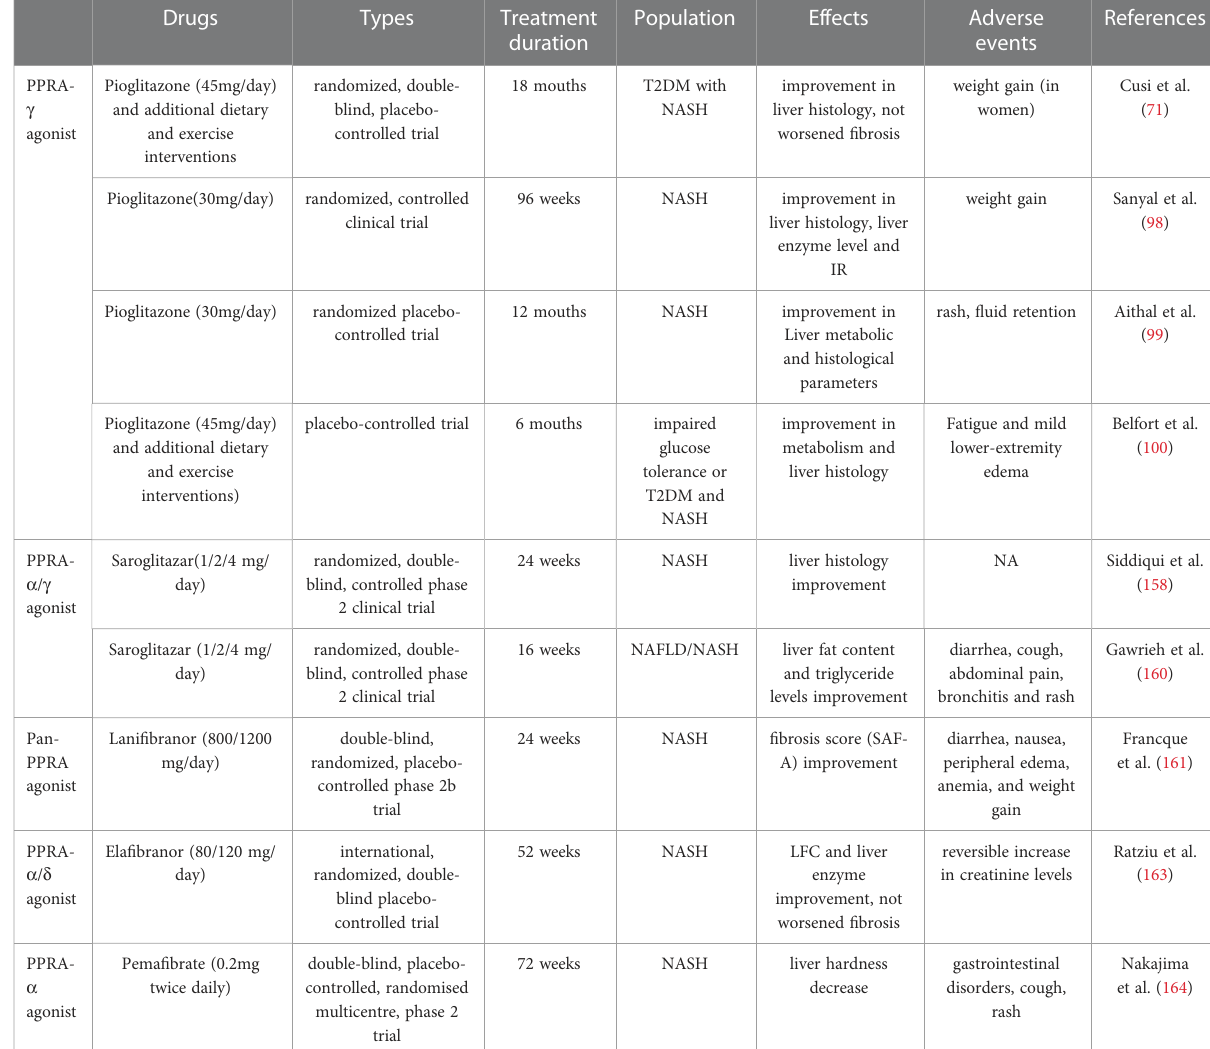
TABLE 3 Effect of PPRA agonist in patients of NAFLD/NASH: Data from clinical